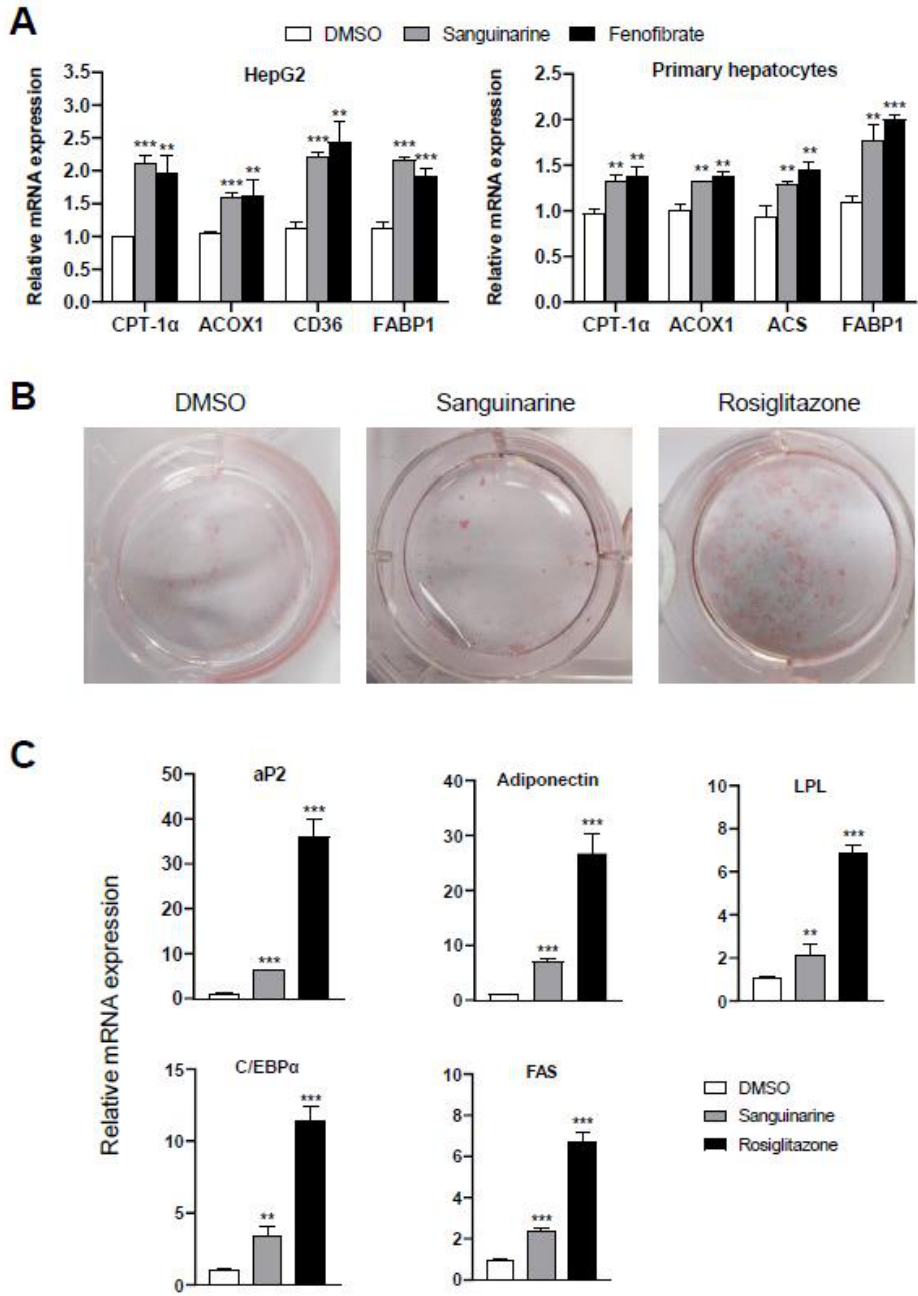
Figure 3. Effects of sanguinarine on PPAR α / γ -target gene expression in cells. ( A ) Expression of PPAR α -target genes. HepG2 cells and mouse primary hepatocytes were treated with either sanguinarine (1 µ M) or fenofibrate (50 µ M) for 48 h. ( B ) Oil red O staining of 3T3–L1 cells after treatment with 1 µ M ligands was indicated for 7 days. ( C ) PPAR γ -target gene expression during the adipocyte differentiation of 3T3–L1 cells induced by 1 µ M ligands. The results equate to the average of experiments performed in triplicate, with error bars indicating SDs; ** p < 0.01, *** p < 0.01, compared with vehicle.